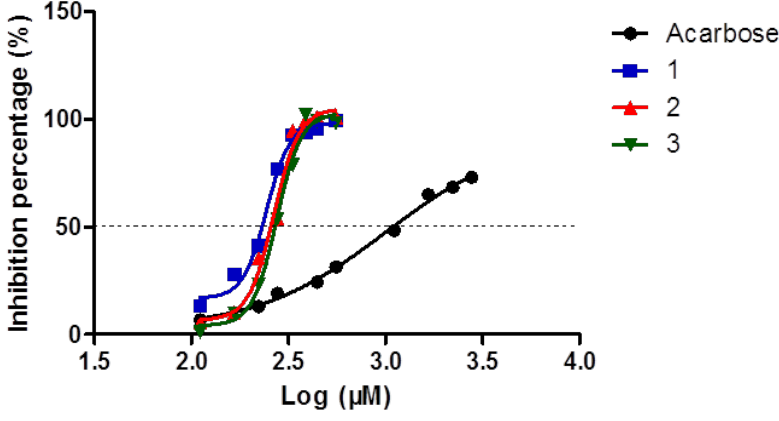
Figure 3. α -Glucosidase inhibitory effects of acarbose and three flavonoid glycosides: vitexin ( 1 ); isovitexin ( 2 ); isorhamnetin 3- O - β - D -rutinoside ( 3